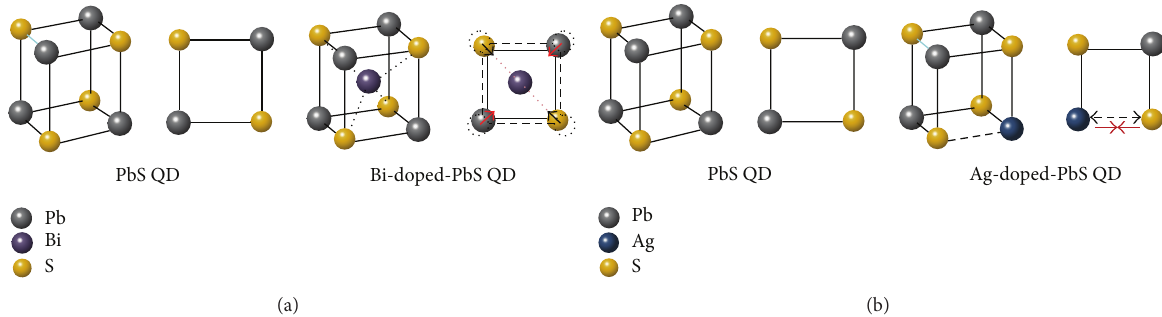
Figure 8: The ball-stick mode of quantum dot unit cells: (a) PbS and Bi-doped-PbS and (b) PbS and Ag-doped-PbS.